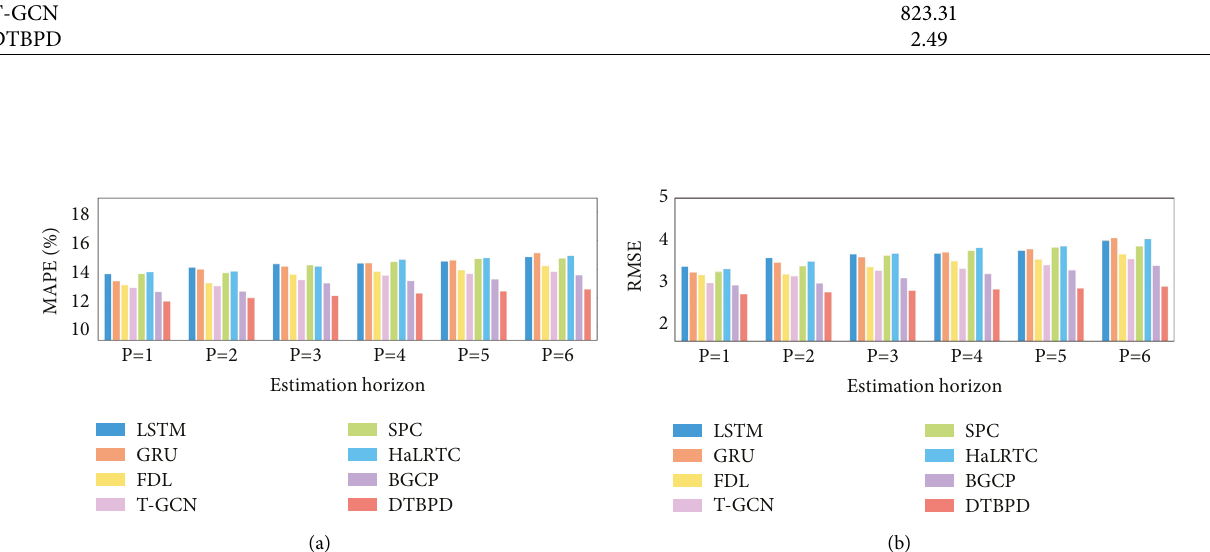
Figure 14: Comparison of different models with longer estimation horizons. (a) MAPE; (b) RMSE.